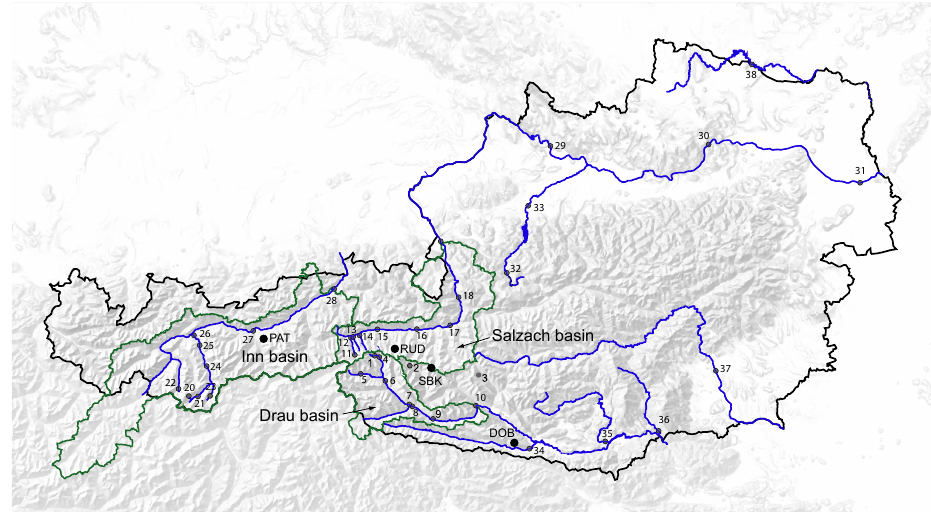
Fig. 3. Overview of investigated gauging stations (grey dots). Station numbers according to Table 2. Black dots indicate elevated meteo- rological stations: DOB=Dobratsch, PAT=Patscherkofel, RUD=Rudolfshuette, and SBK=Sonnblick (see Fig. 2). Green lines show the three main glacierized basins Inn, Salzach and Drau (data source BMLFUW,